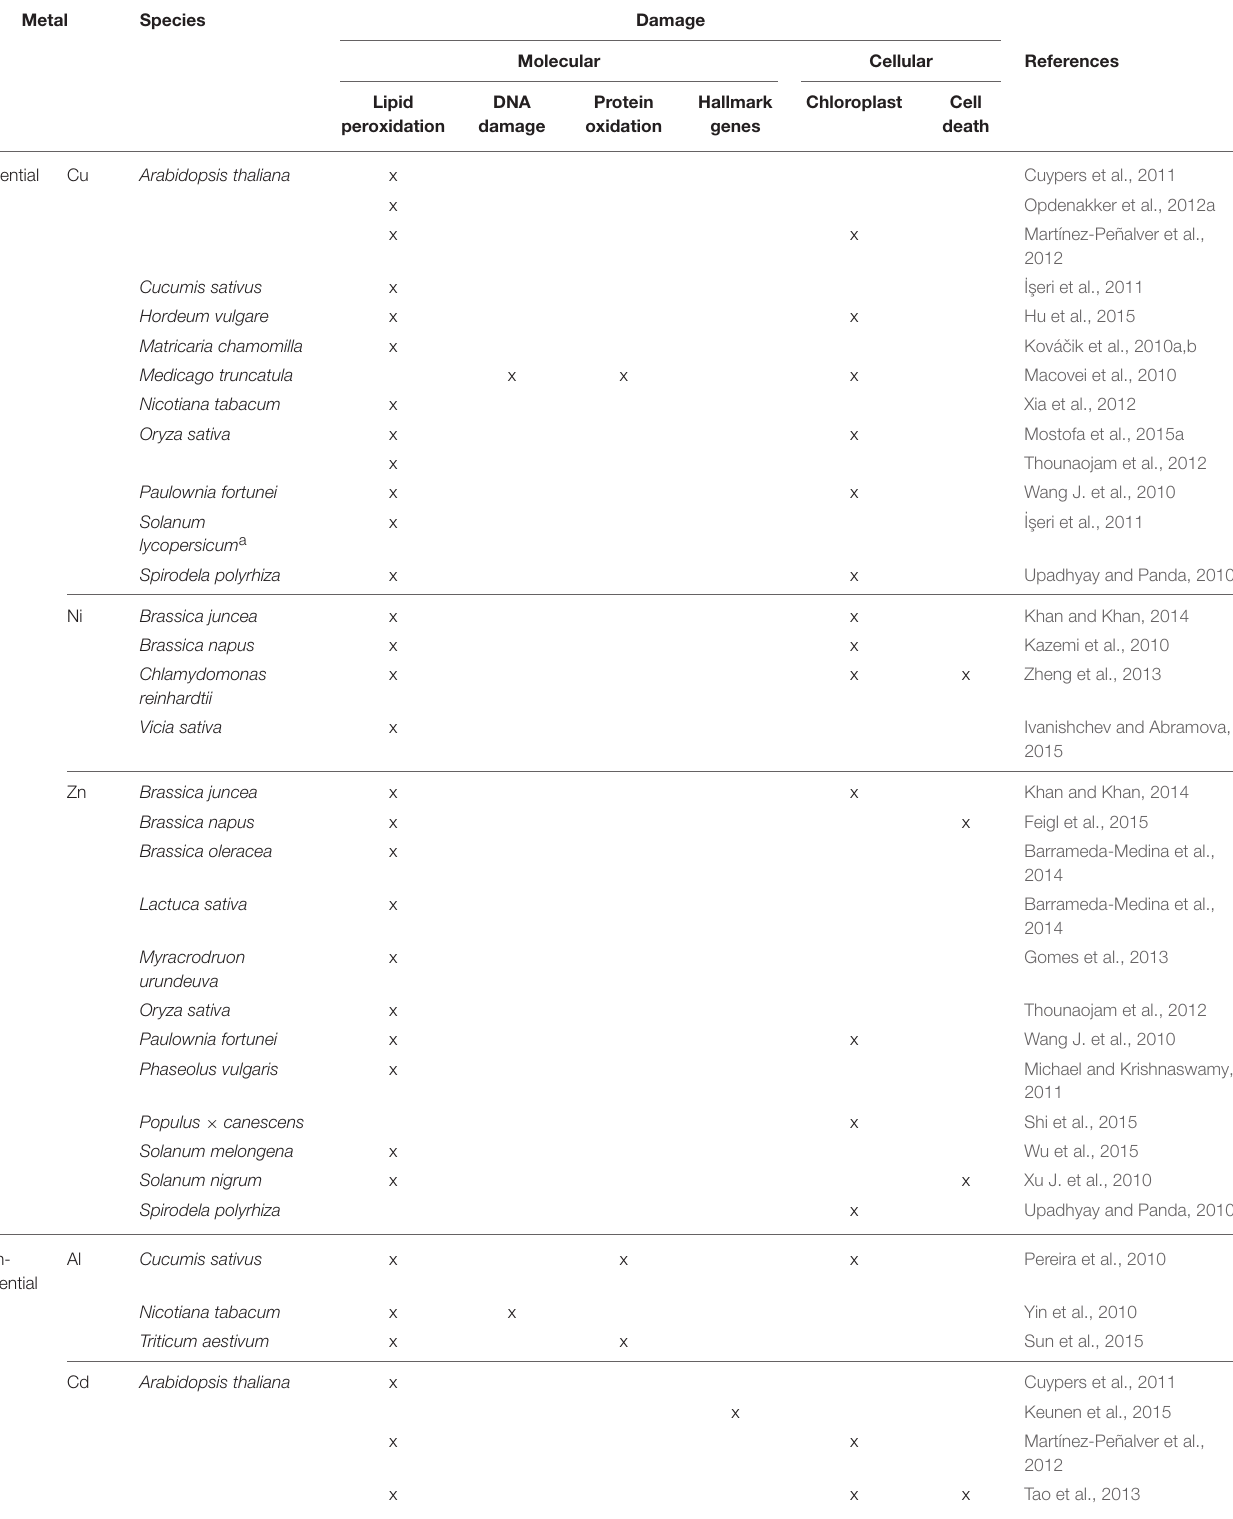
TABLE 2 | Oxidative damage in plants related to an elevated H 2 O 2 content induced by metal exposure.